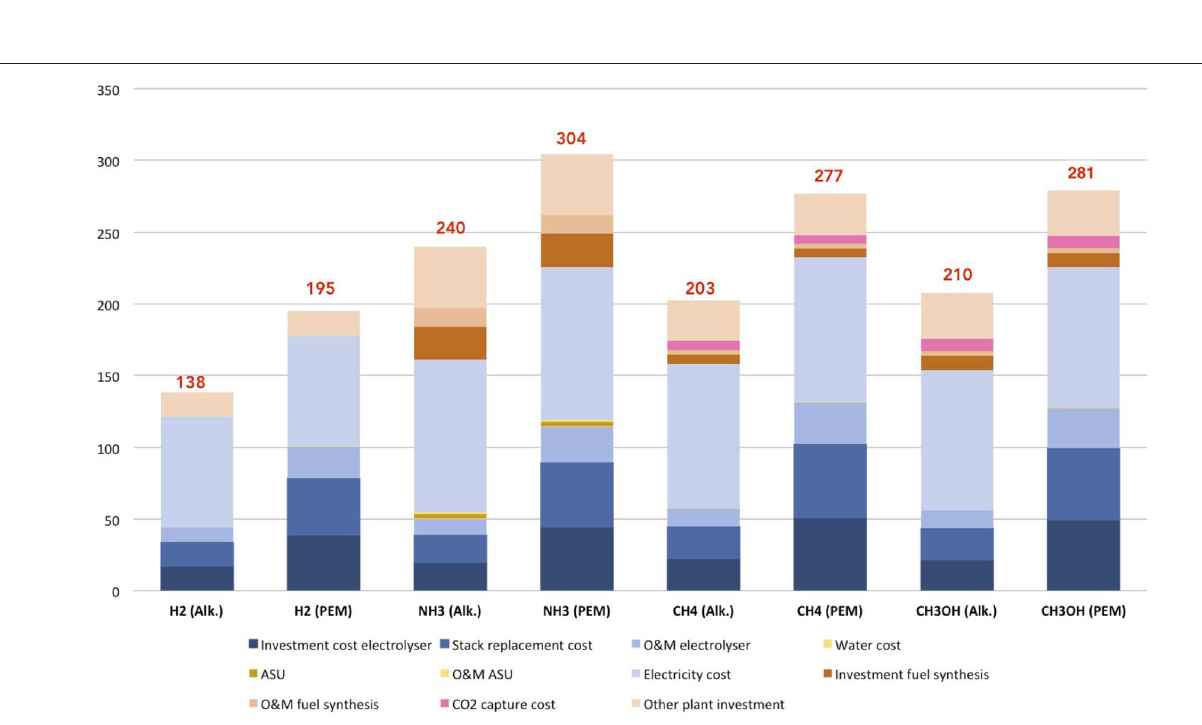
Frontiers in Mechanical Engineering |